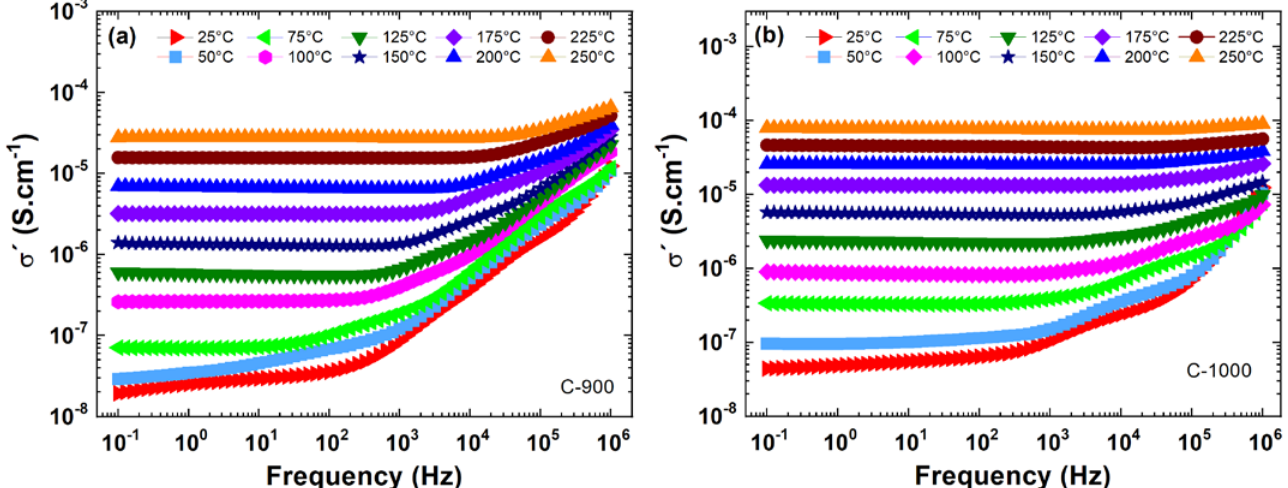
) versus frequency ( ) for ceramic pellets sin- ′ 𝜎𝜎 𝑓𝑓